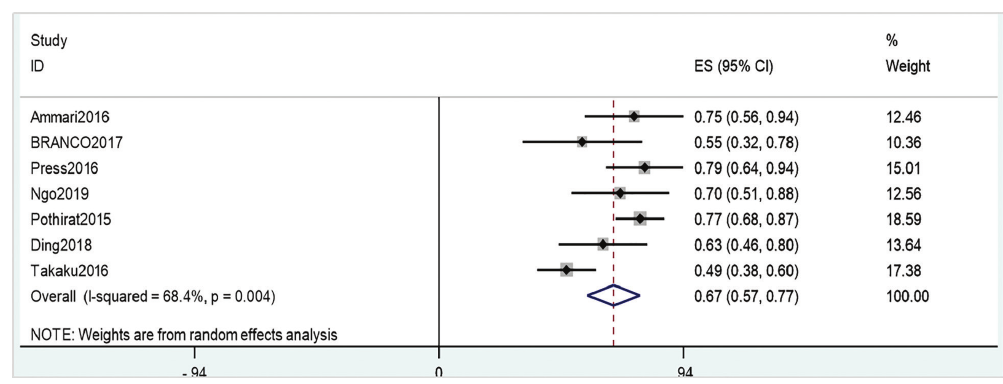
Figure 6. Forest plot of error rates for quantified inhaler use.